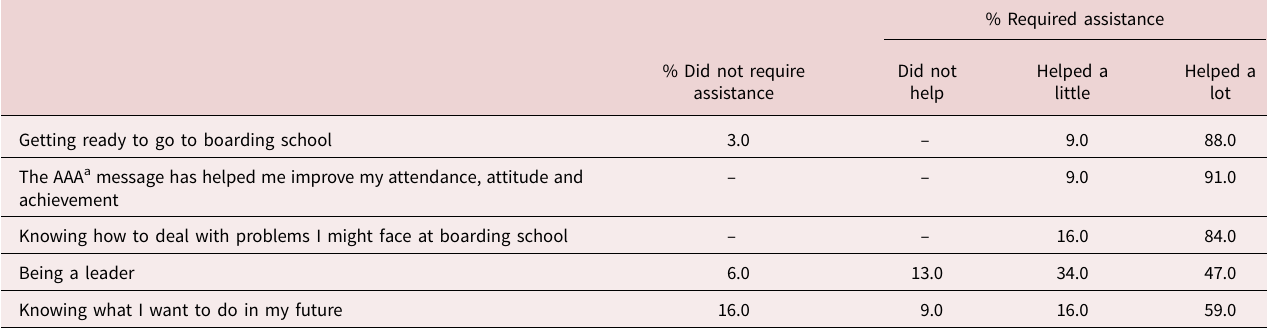
Table 4. TSS areas of assistance for primary students ( n